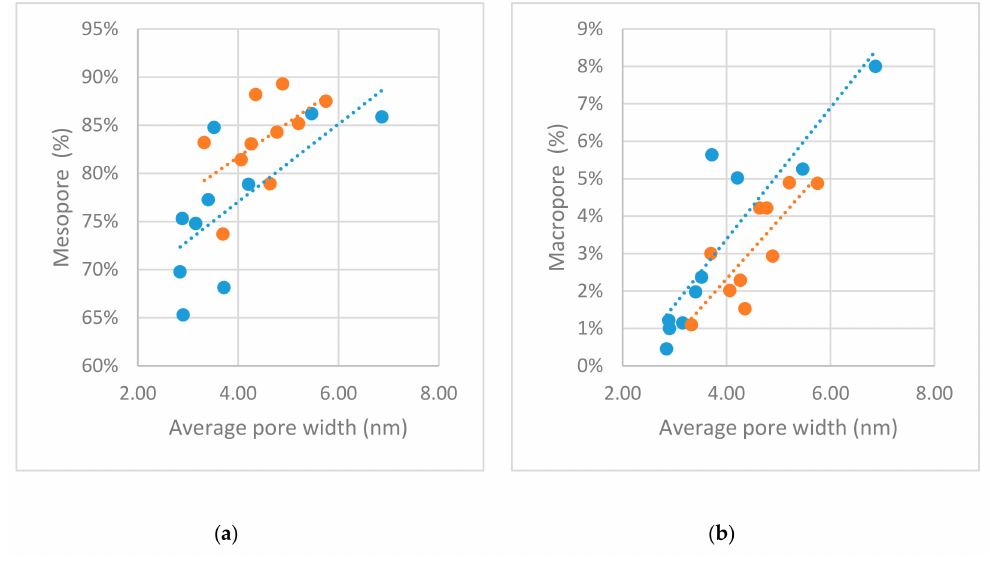
Figure 20. Relationship between average pore width vs mesopore percentage ( a ), and macropore percentage ( b